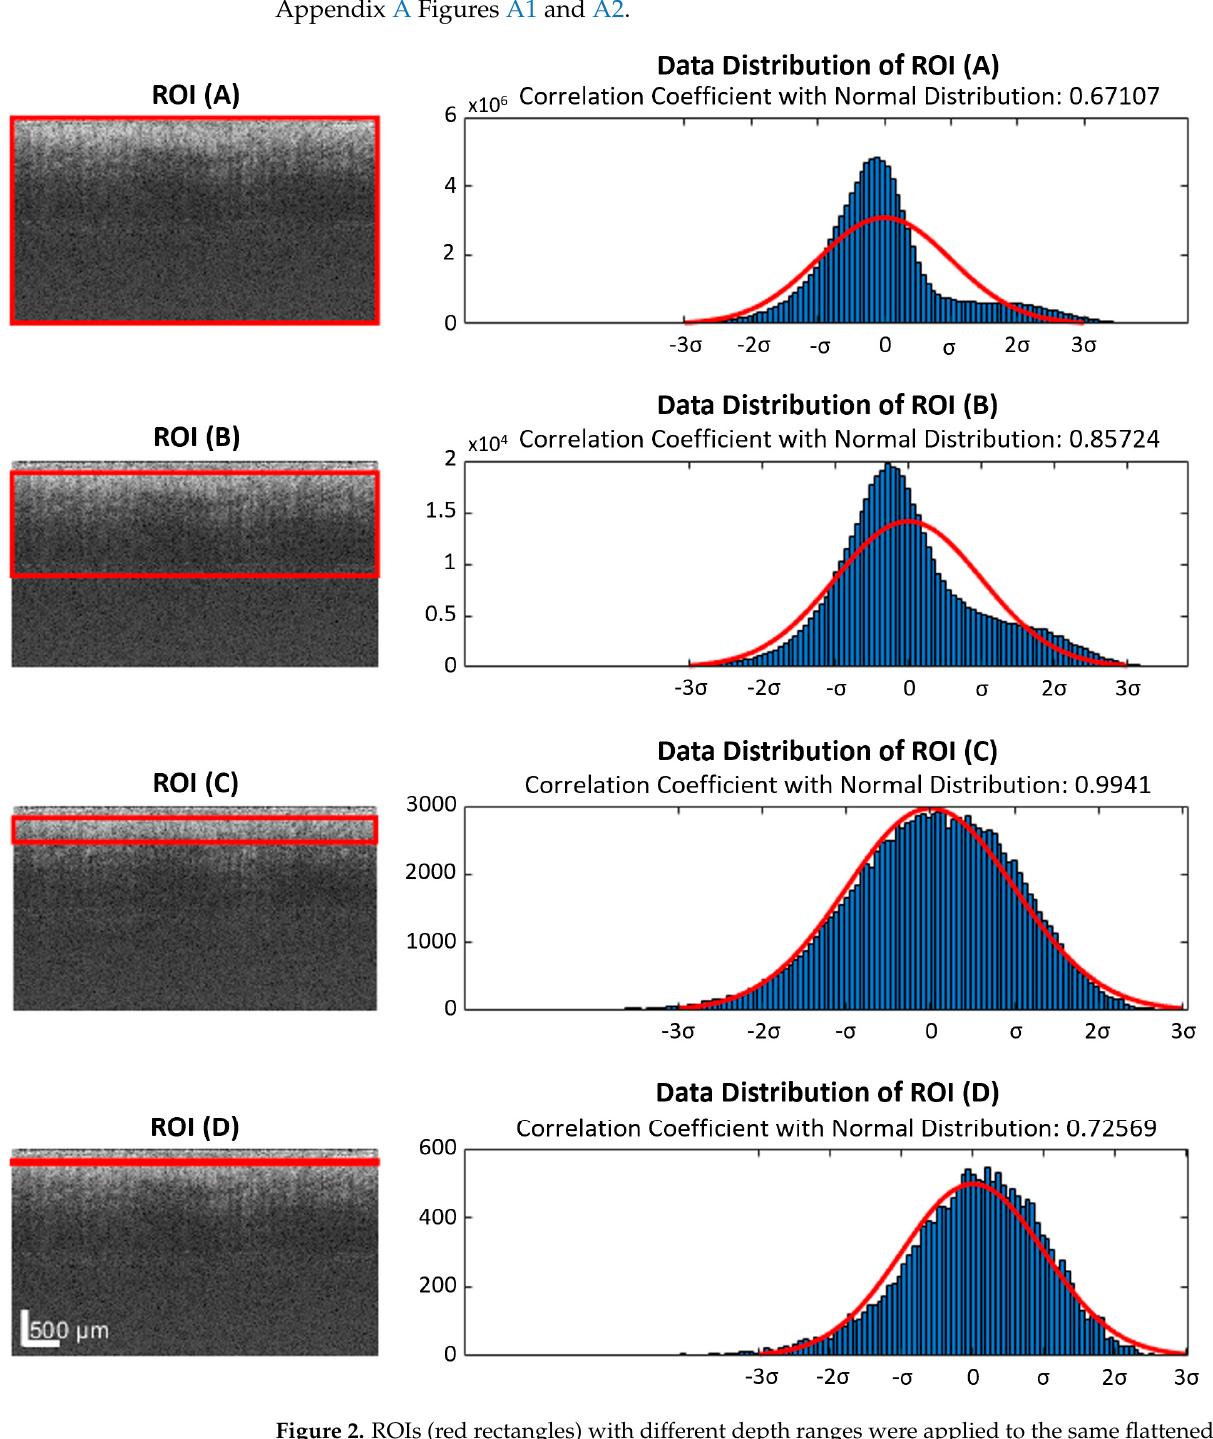
Figure 2. ROIs (red rectangles) with different depth ranges were applied to the same flattened raw data. The selected data were plotted in histograms, which were compared with fitted normal distributions. ( A ) All data from the slice, which were 4 repeated B-scans contributing a 340 × 600 × 4 matrix. ( B ) A large ROI with half of the depth range, 170 pixels, was selected. ( C ) A small ROI with a depth range of 40 pixels. ( D ) An extremely small depth range of 5 pixels. ROI: region of interest.